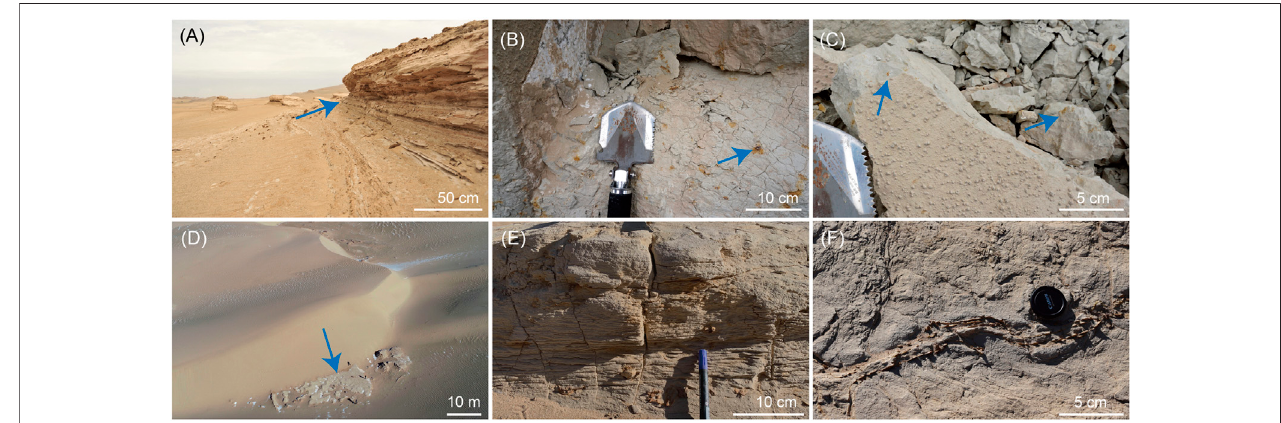
FIGURE 2 | Sampling sites and samples from the western Qaidam Basin. (A) Deposits are exposed on the side of a yardang (blue arrow). (B,C) Yardang samples (0718 and 0719) with rusty concretions (blue arrows). (D) Deposits (yellow arrow) are covered by sand dunes from the view of a drone. (E,F) Dune-covering samples (1222-3A and